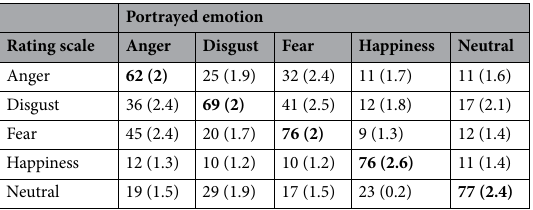
Table 1. Mean intensity ratings for all portrayed emotions by a rating scale. Intensity was measured on a scale from 1 to 100. The table presents means and standard errors in brackets. Values on the rating scale corresponding to the portrayed emotion are in